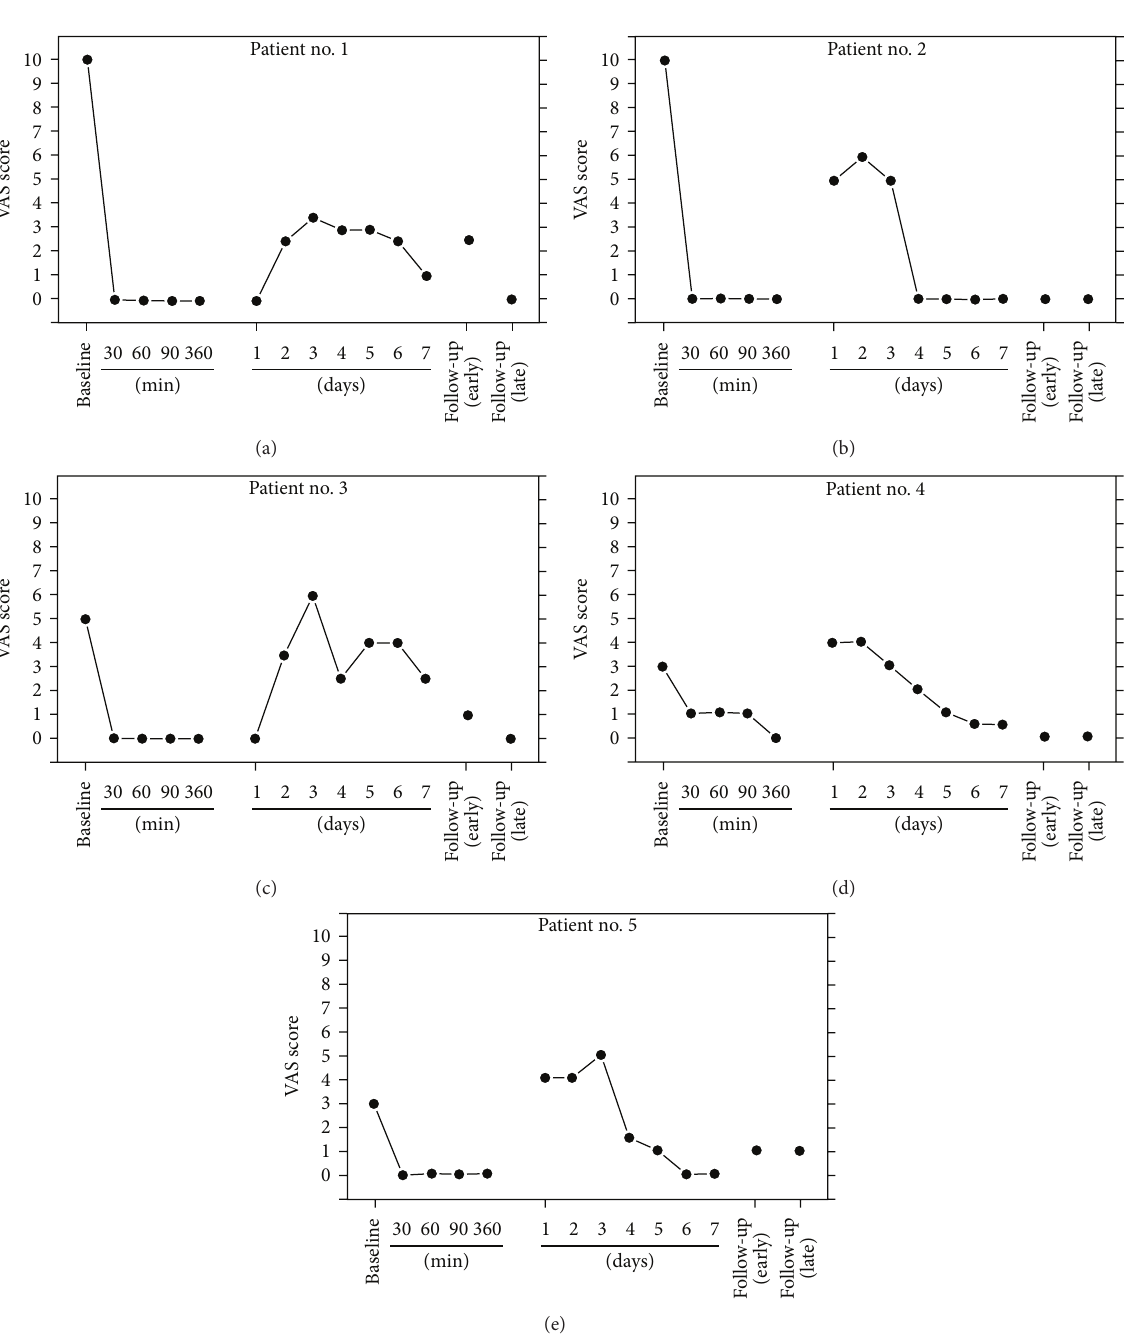
Figure 1: Baselineand postprocedureVAS scoresfor patients treated by intravenous regional blockade with phenoxybenzamine. Early follow- up evaluation times were at 6, 8, 11, 27, and 11 days after the procedure for patients 1, 2, 3, 4, and 5, respectively. The latest follow-up evaluations were at 17, 7, 5, 9, and 7 months for patients 1, 2, 3, 4, and 5, respectively. Reproduced with permission from Anesthesiology , 1998